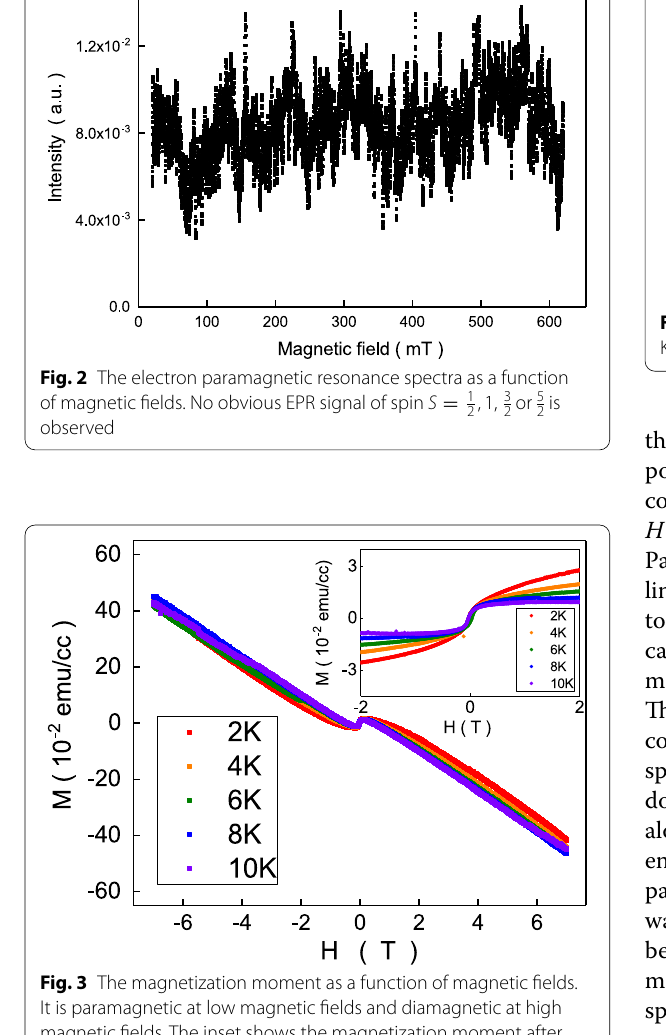
− 2.15 × 10 − 4 emu/cc Oe and is consistent with reported values in various kinds of topological insulator. Figure 3 inset shows the magnetic moment without the diamag- netism contribution.